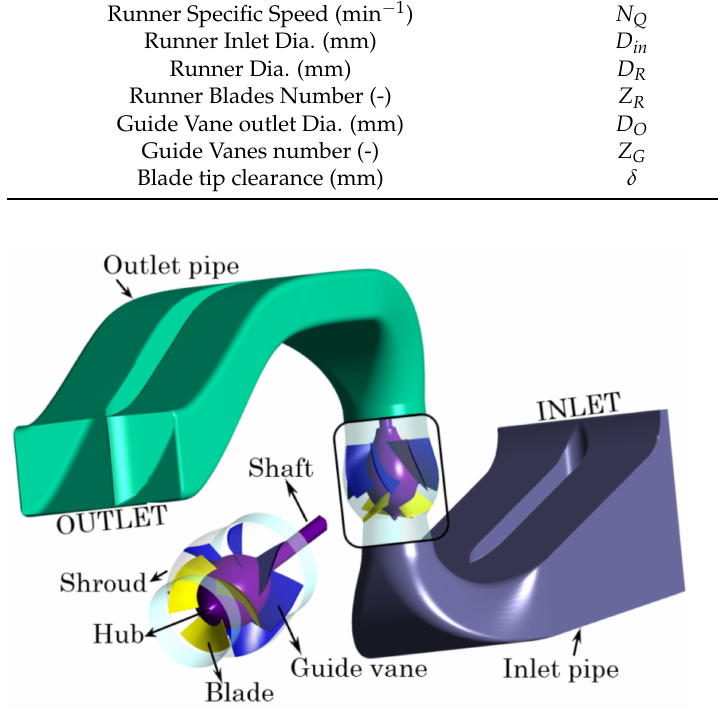
Figure 1. PAT computational domain and